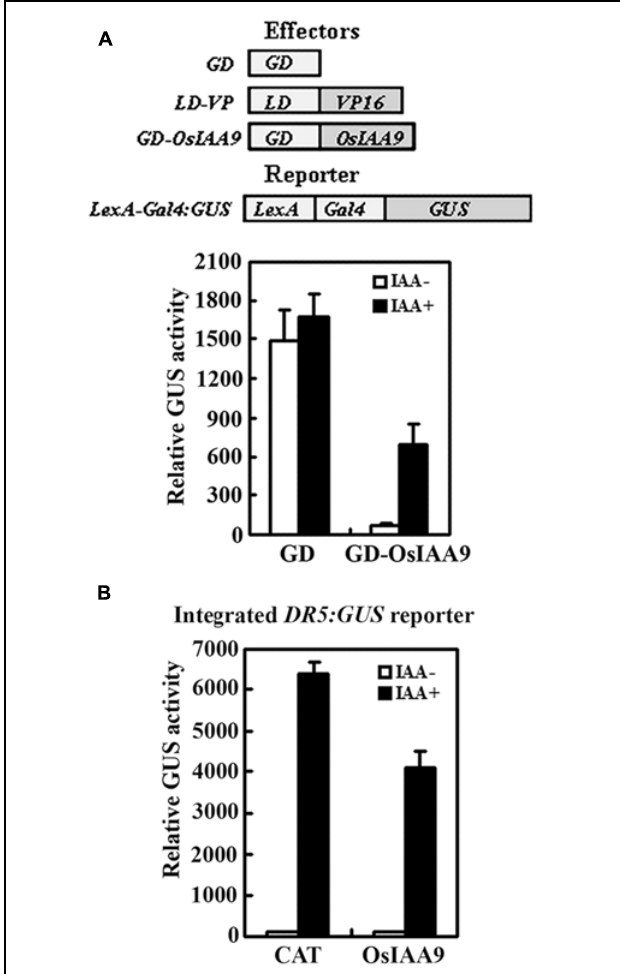
FIGURE 3 | OsIAA9 is a transcriptional repressor and its stability is affected by auxin. Repression of LexA-Gal4:GUS reporter gene (A) , and the integrated DR5:GUS reporter gene (B) by OsIAA9. Effectors and reporters (drawn on the top of A ) or effectors plasmids alone were transfected into protoplasts isolated from Col wild type, or DR5:GUS transgenic plants, and incubated in the presence and absence of 1 µ M IAA for 20–22 h, then GUS activity was assayed. The 35S:CAT (chloramphenicol acetyltransferase) plasmids were used as a control. Data represent the mean ± SD of three